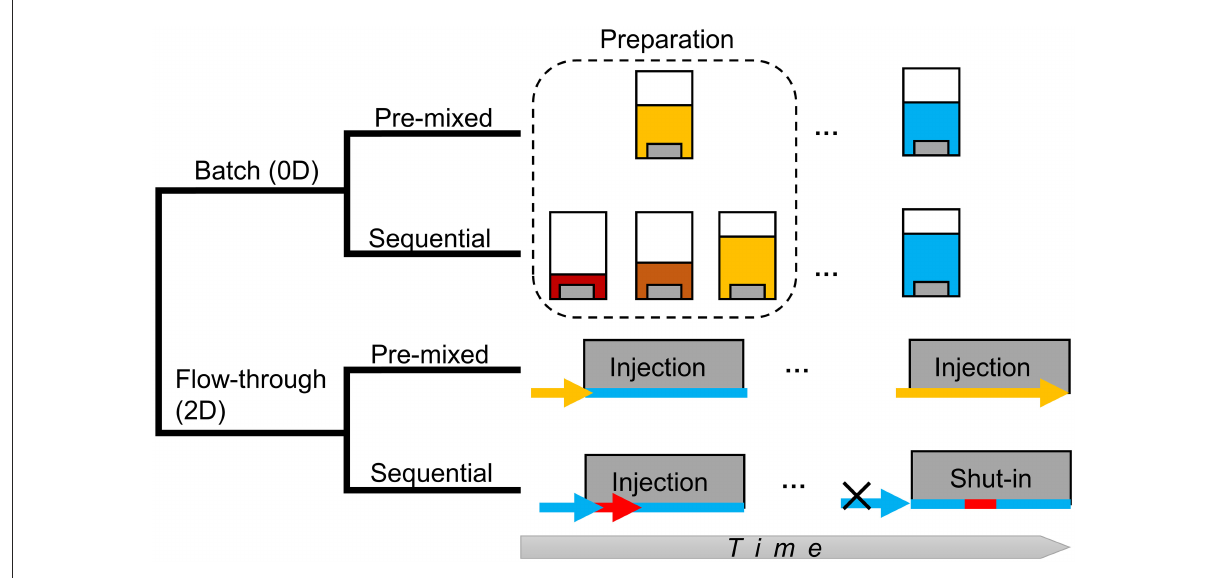
FIGURE1 Schematics of models in this study. Solution acidity is illustrated by different colors. The warmer the color, the stronger the acidity. Concentrated HCl is shown in red, less concentrated HCl is orange, dilute acid (the pre-mixed condition) is yellow, and slickwater is